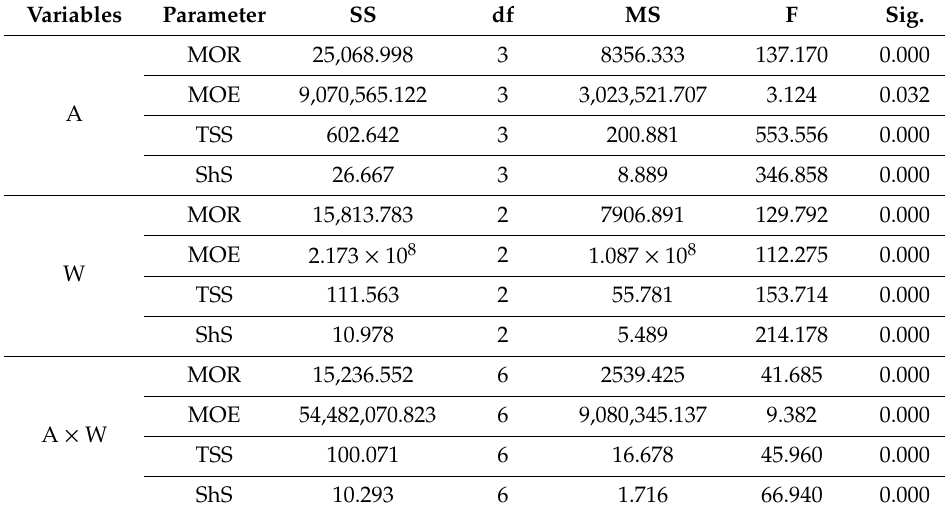
Table A2. ANOVAs of the variable parameters on the mechanical properties of plywood panels.